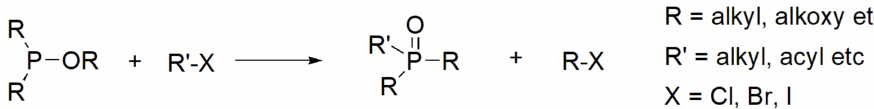
Figure 1. Examples of important compounds bearing the P–C